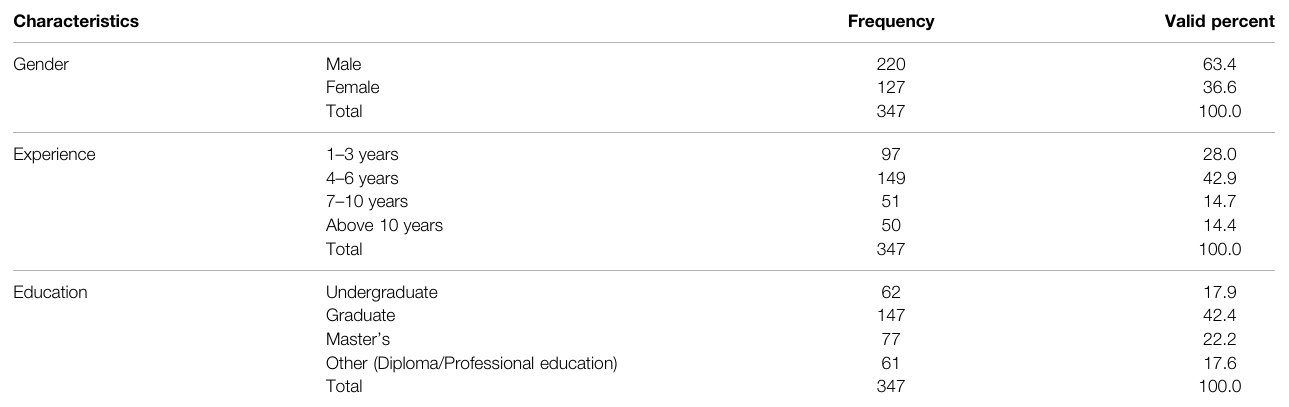
TABLE 1 | Respondent characteristics.